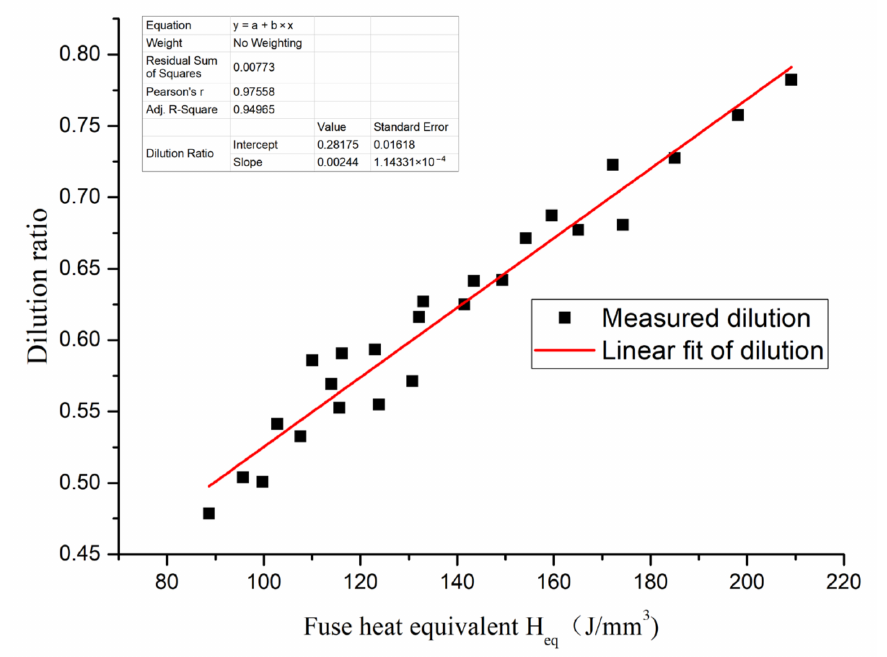
Figure 7. The linear relationship between the fuse heat equivalent and the weld dilution